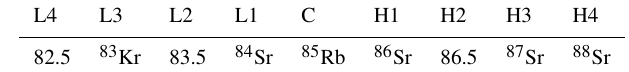
Table 1. Standard cup configuration and analysed masses (amu or isotope mass) employed for solution strontium isotope analysis on the Neptune MC-ICP-MS at the Research School of Earth Sciences, the Australian National University.